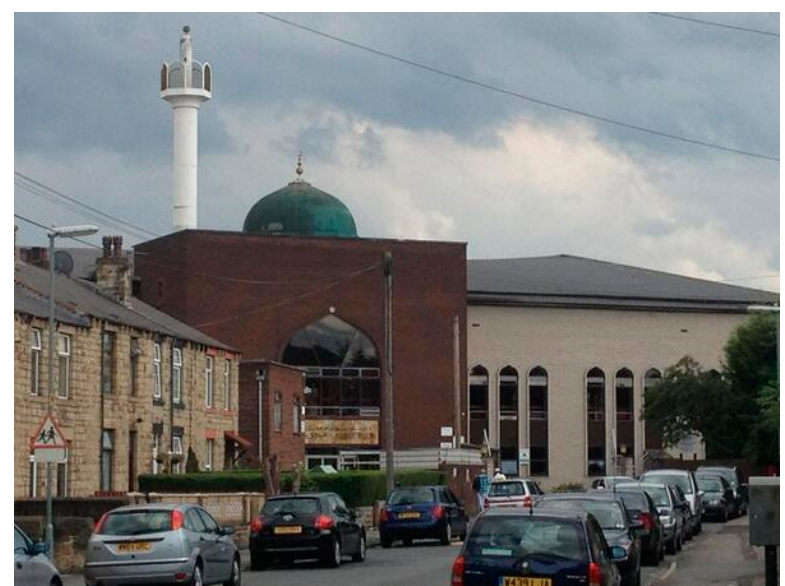
Figure 1. The Tablighi Jama’at (TJ) headquarters in Dewsbury, West Yorkshire. Source: http://www.beautifulmosque.com/Markazi-Mosque-in-Dewsbury-United-Kingdom (accessed on 21 June 19).